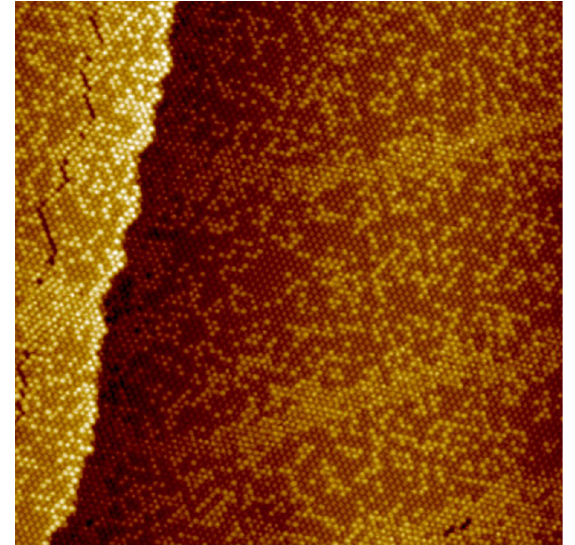
Figure 3: STM image (76 × 76 nm 2 ) of a large dis-R30° domain with a low ratio of bright molecules and stripes consisting of accumulated bright molecules ( U bias = 1.96 V, I T = 0.10 nA, sample A3). Further- more a crack is visible within the dis-R30° domain.